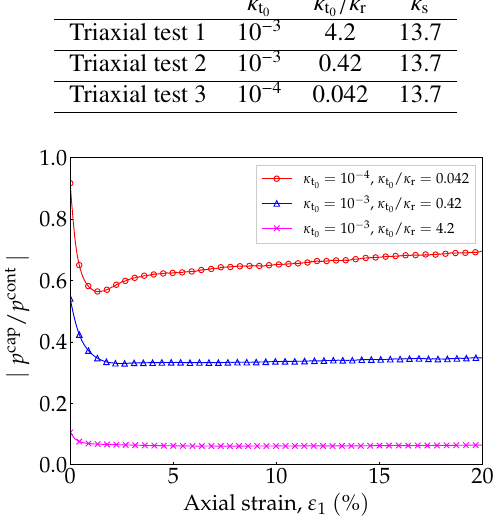
Figure 1. The evolution of mean capillary stress during DEM triaxial tests.